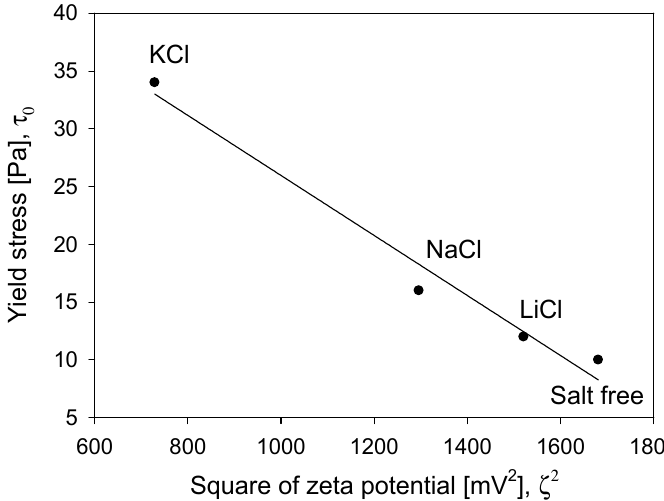
Figure 13. The relationship between the square of zeta potential (0.01 M) and pulp yield stress (0.5 M) obtained at pH 6.2.